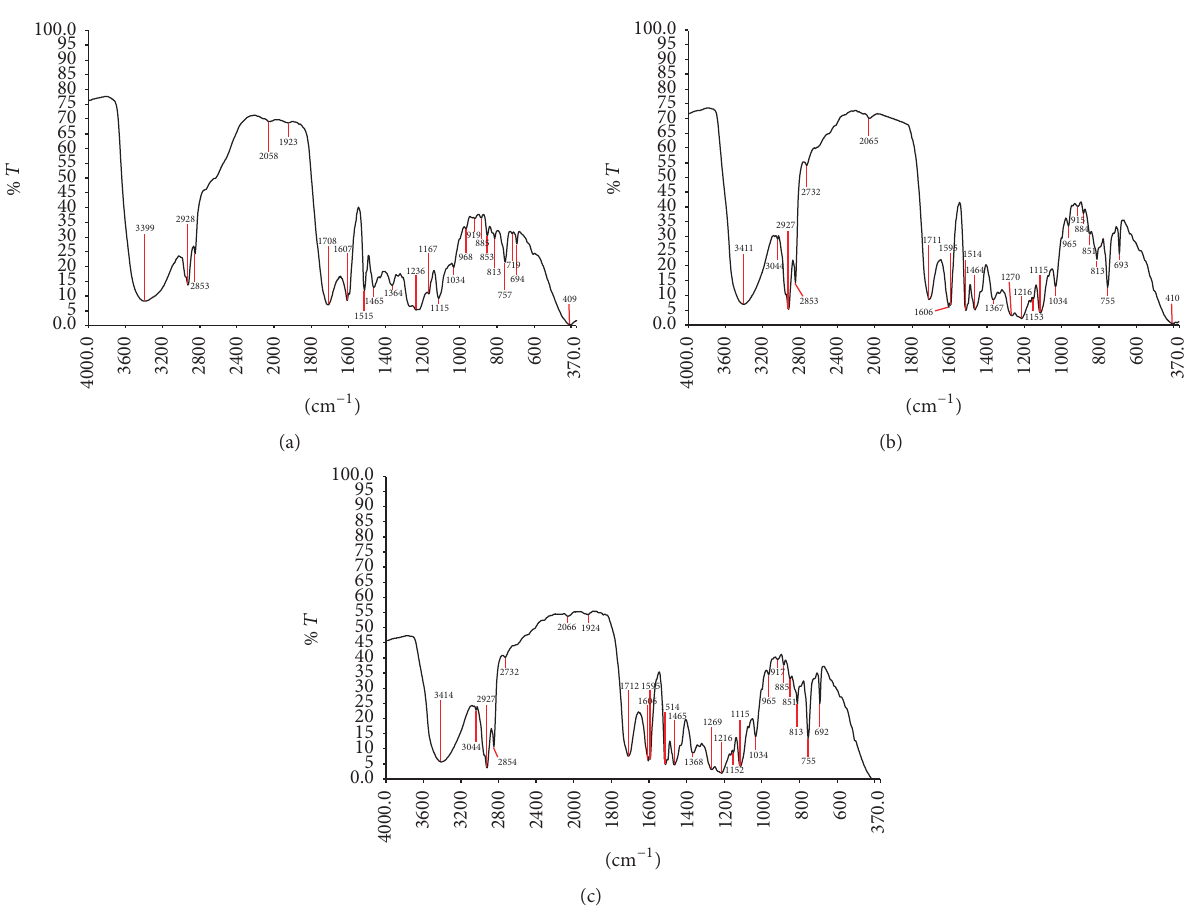
Figure 3: IR spectra of PKO and EO; (a) PKO and (b) EO concentrated at 35 ∘ C; and (c) EO concentrated at 78 ∘ C.